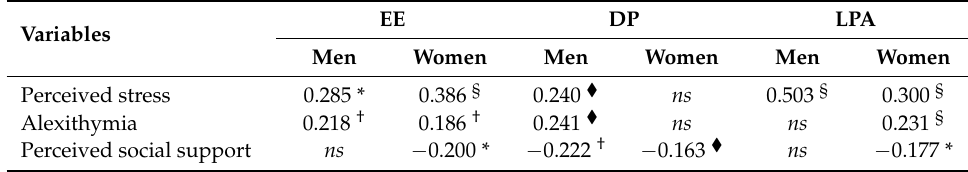
Table 2. Pearson’s correlation matrix.